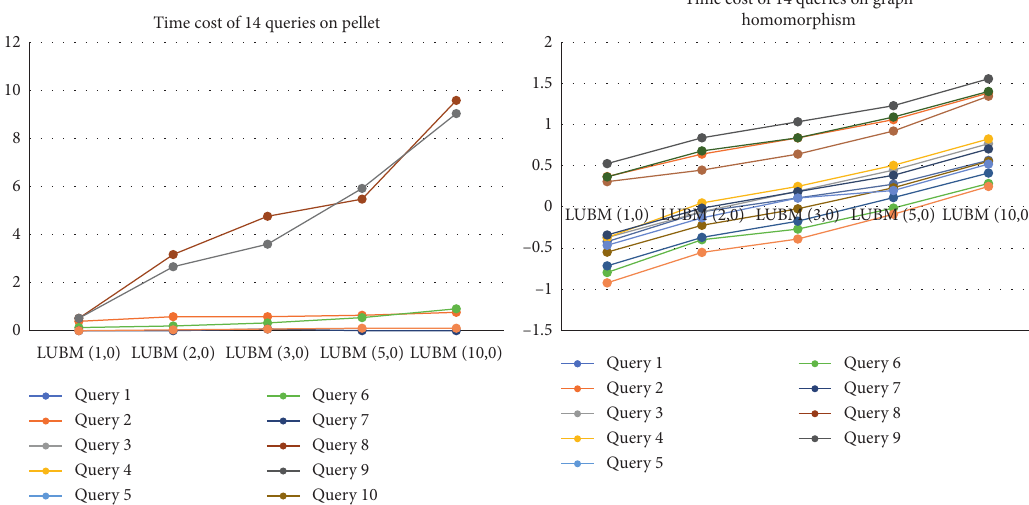
Figure 10: Time cost of executing 14 LUBM